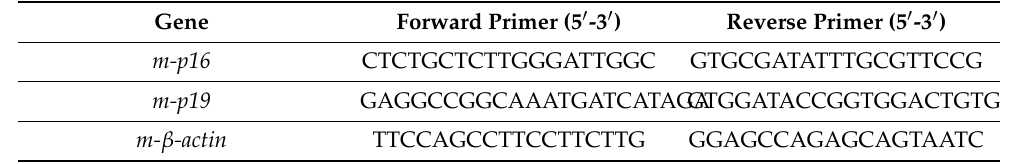
Table 2. Sequences of specific primers were used in this